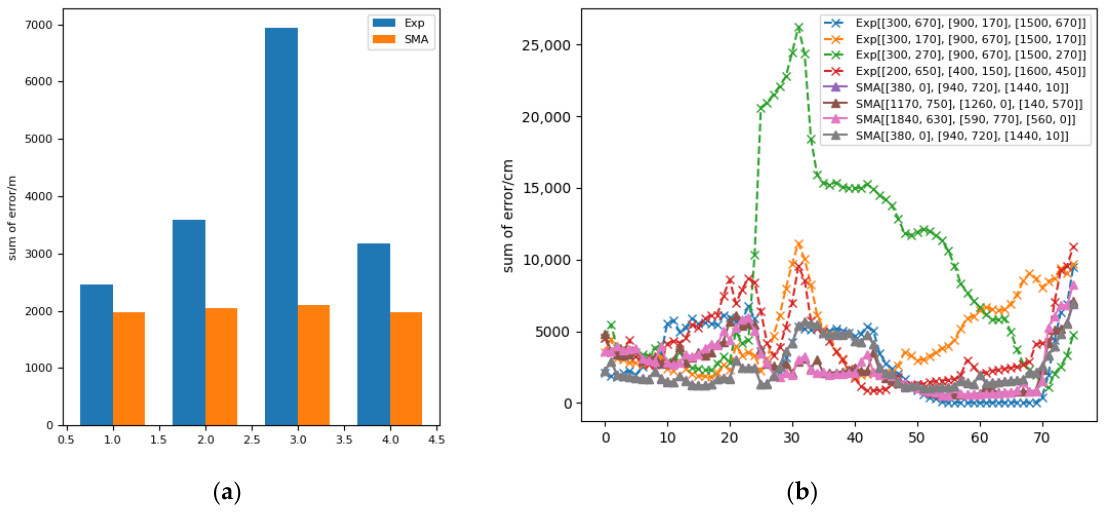
Figure 7. ( a ) Comparison of the spatial positioning error between the anchor position optimized by SMA and the anchor position placed by experience (Exp). ( b ) Comparison of positioning errors in different regions.